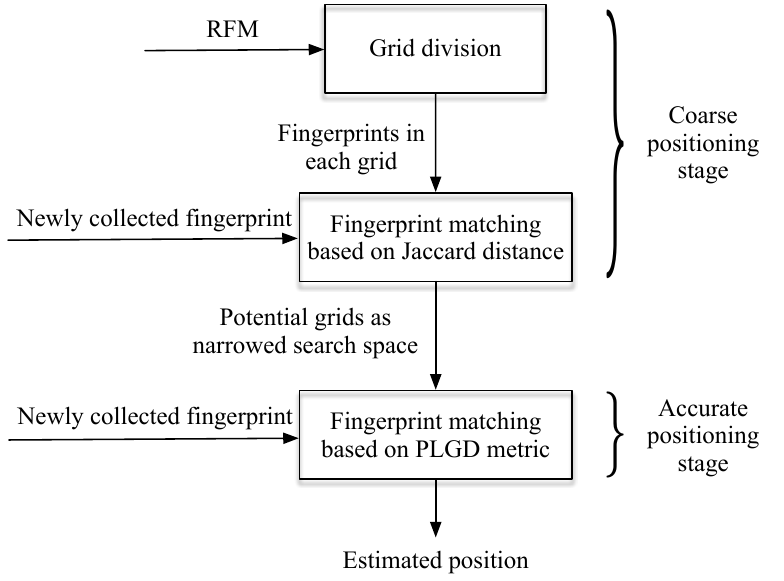
Figure 2. The hierarchical structure for Wi-Fi based positioning in our